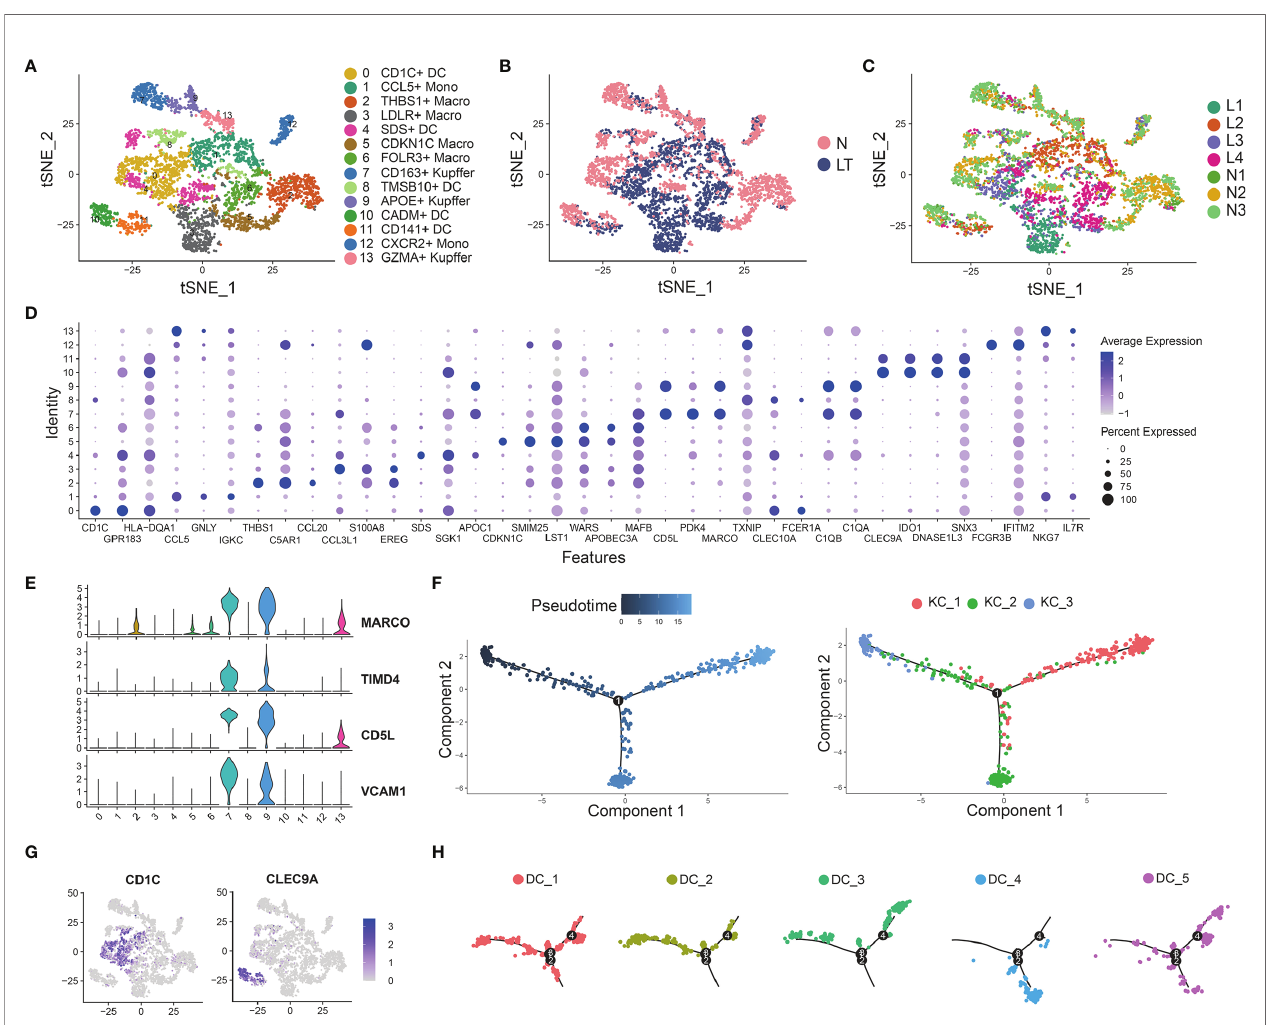
FIGURE 5 | Identifying myeloid cell subpopulations in liver tissue. (A) Clustering of 4883 myeloid cells and cell annotation. (B) tSNE plots colors by spatial distribution of cells in normal (n=3) and liver transplantation (n=4) human tissues. (C) tSNE plots colors by spatial distribution of cells in 7 samples. (D) Dotplots of each cluster of myeloid cells ’ top 5 marker genes. (E) Gene expression of Kupffer cells ’ canonical markers across myeloid cells. (F) Pseudotime analysis with identi fi ed 3 Kupffer groups. (G) Gene expression of dendritic cells ’ canonical markers across myeloid cells. (H) Pseudotime analysis with 5 dendritic cell